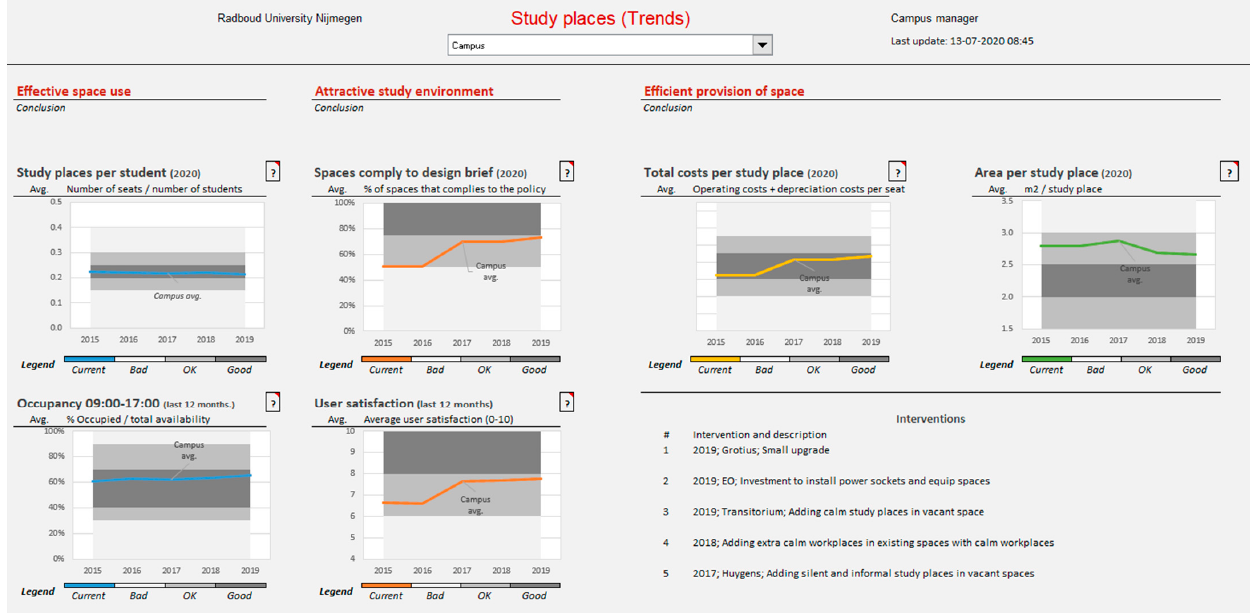
Figure 6. Trends dashboard ‘Study places RU’ (tested in workshop 2).